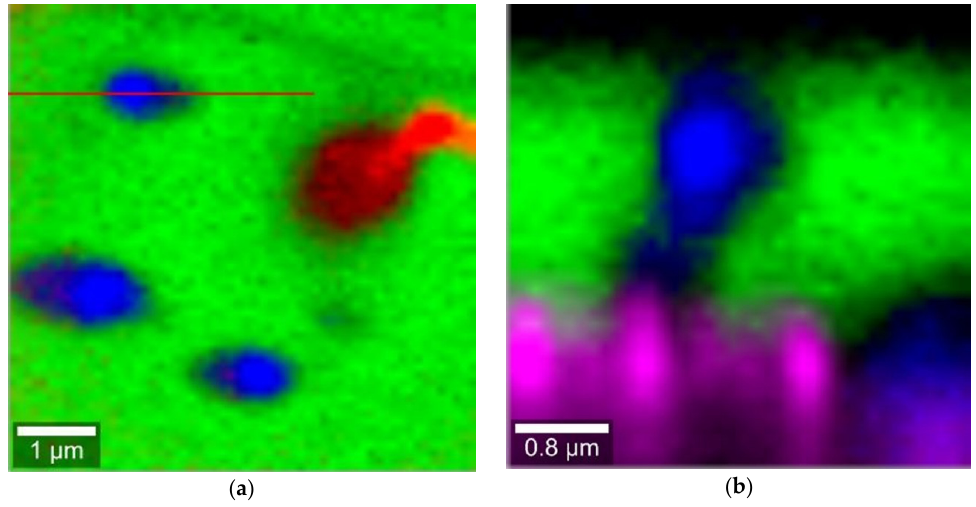
Figure 7. ( a ) Raman image in the X – Y direction; ( b ) analysis of red line zone depicted in (a) showing the position of the Raman image in depth in the X – Z direction.